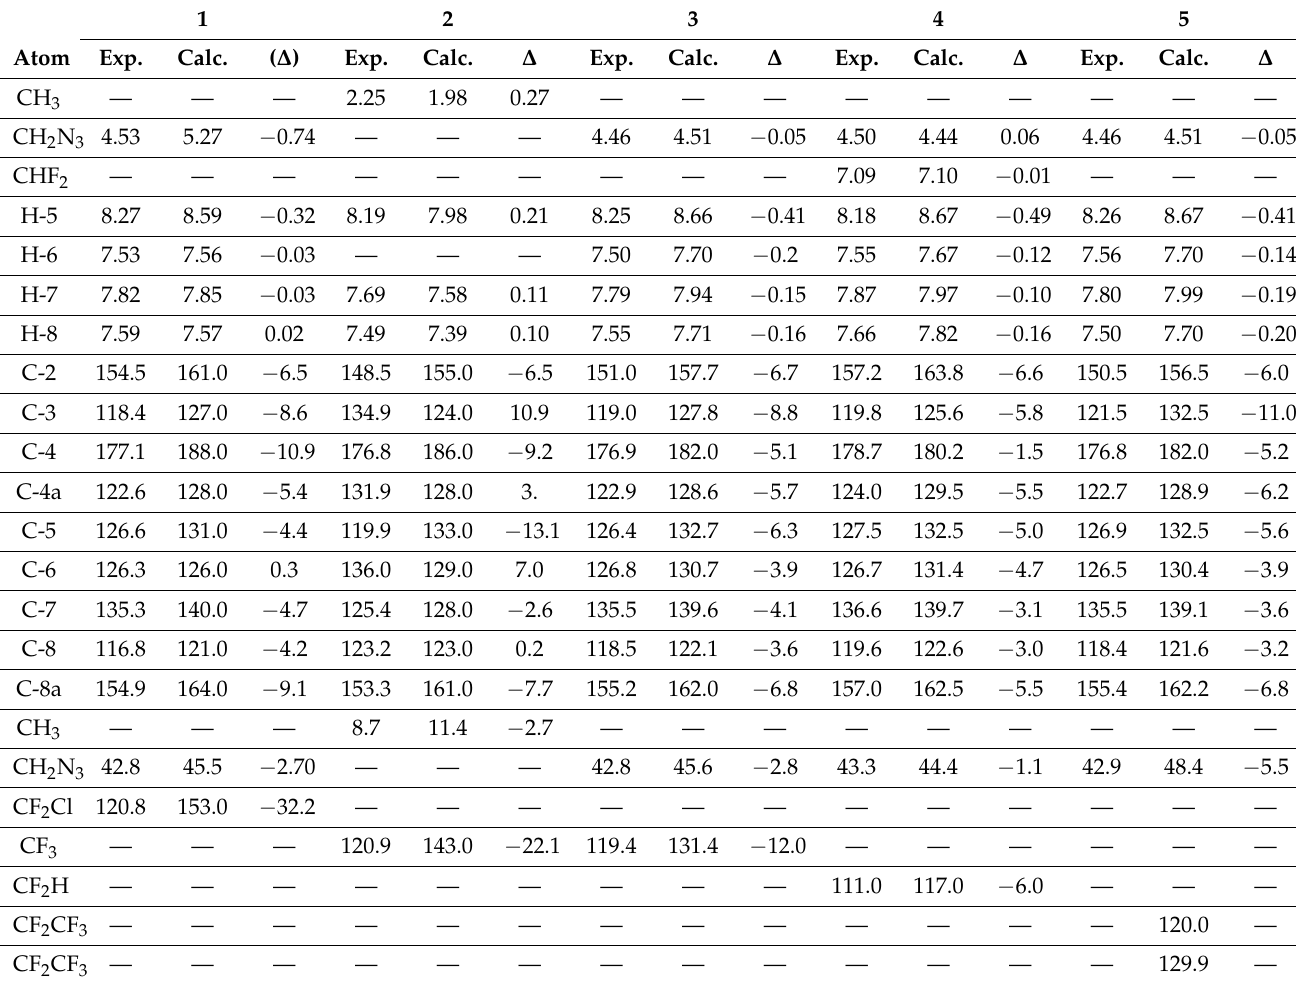
Table 2. Comparison between experimental and calculated chemical shifts (ppm) of 1 H and 13 C-NMR spectra of compounds 1 – 5